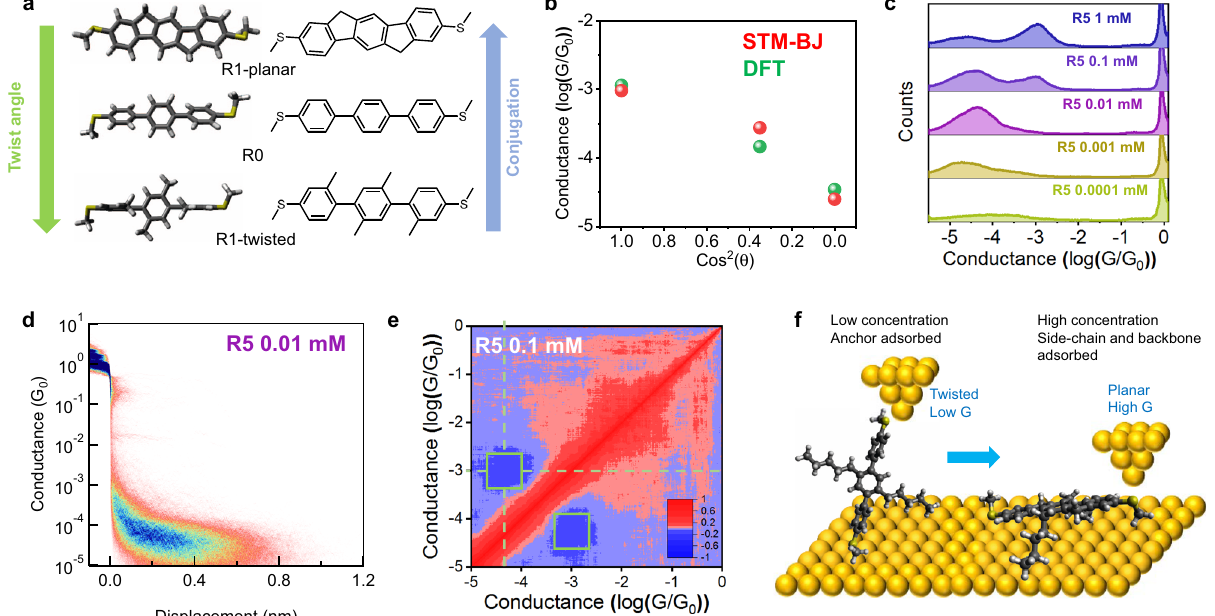
Fig. 3 Molecular origin of the high conductance state. a Terphenyl derivatives with different conformations. b Peak molecular conductance values for terphenyl derivatives with different dihedral angles from DFT simulations and experiments. Dihedral angles are determined from the lowest energy conformers using DFT simulations. c 1D molecular conductance histograms showing the concentration-dependent behavior of R5. d Representative 2D conductance histograms of R5 (0.01 mM) showing only the low G state. e 2D correlation of molecular conductance for R5 (0.1 mM). f Schematic showing mechanism for concentration-dependent conformation and conductance behavior of single-molecule junctions. The high G and low G states both arise due to transport through the long axis of the molecule, facilitated by the linkage of the molecule to the tip and substrate between two terminal whether two conductance states occur independently (negative correlation, shown in blue) or sequentially (positive correlation, shown in red) in a single-molecule conductance trace. These results show a clear negative correlation between the high G and low G states (two blue regions in the green boxes), indicating that these two conductance states occur independently and therefore do not occur sequentially in a single-molecule trace.